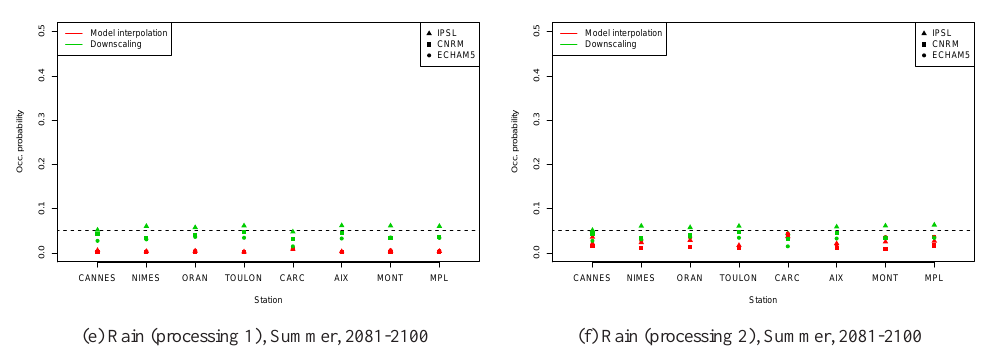
Fig. 12: Same figure as Fig. 7 for extreme rainfall events without (left) or with threshold (right) over 2081-2100 for the whole year (a, b), winter (c, d) and summer (e, f).